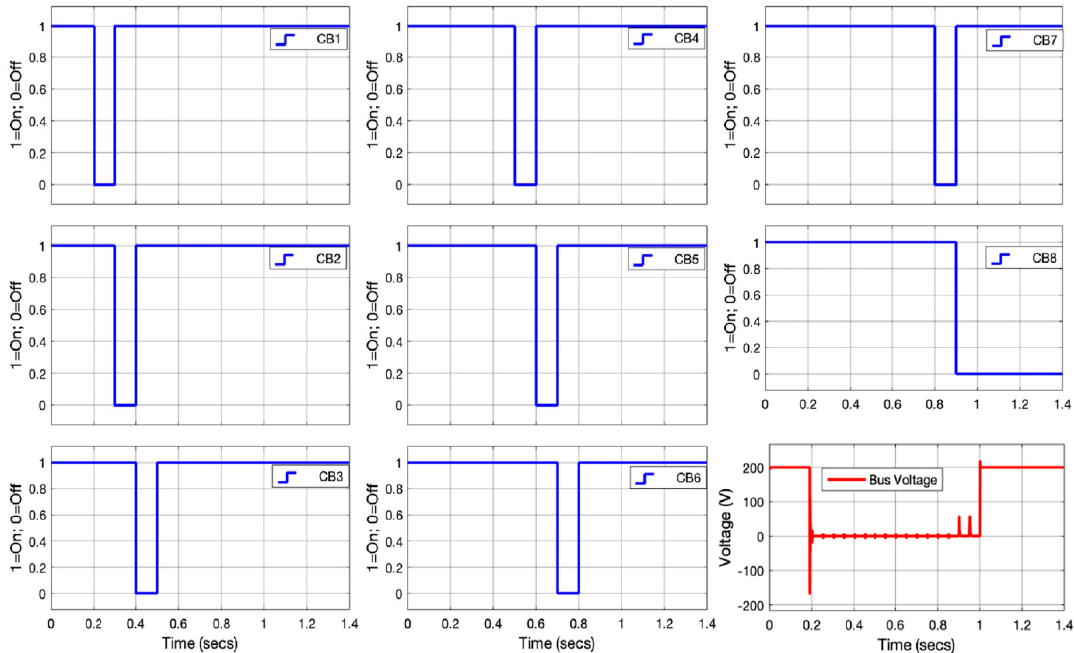
Figure 10. Bus fault searching by opening and closing each relay in the DCMG with the fault de- tected at CB8 in 0.9 s, and the faulty part was isolated, then the grid was